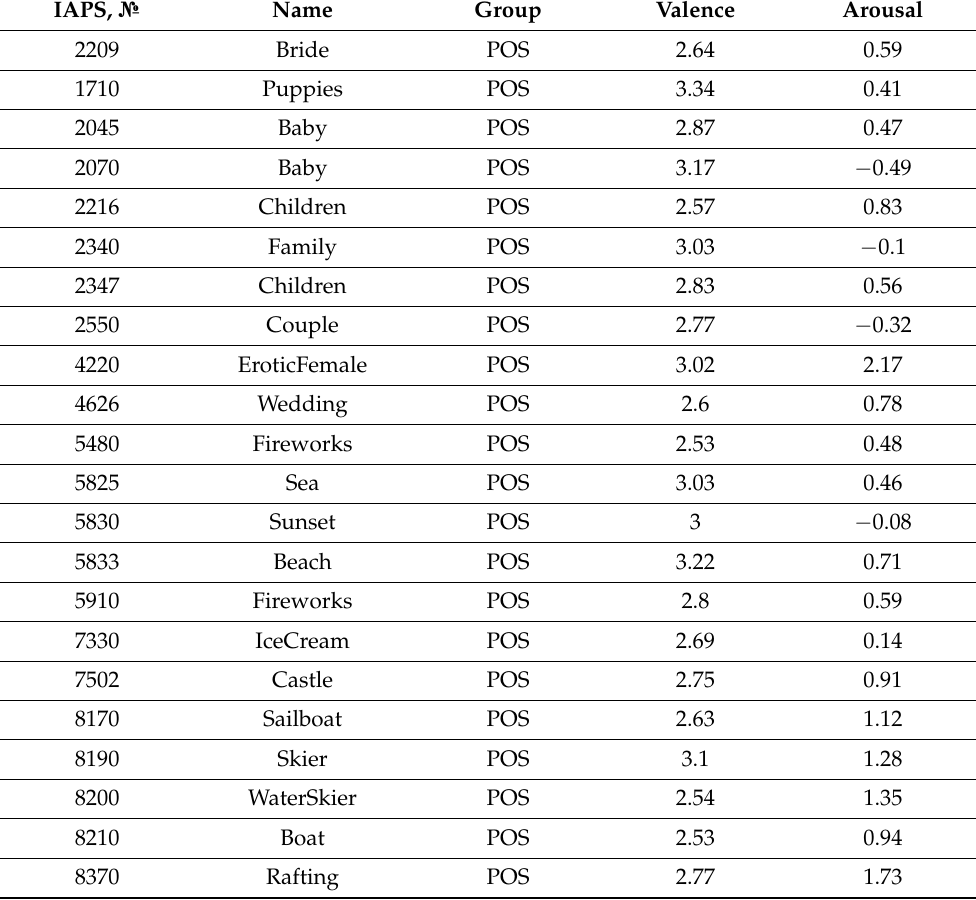
Table A1. Responses of subjects according to the SAM questionnaire to stimulus material from the IAPS database based on an American